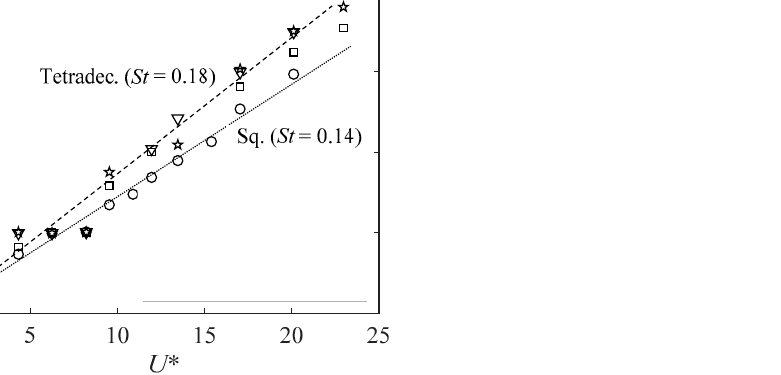
Figure 9. Variation of reduced shedding frequencies on reduced velocities for several polygonal towers (tower-only case).